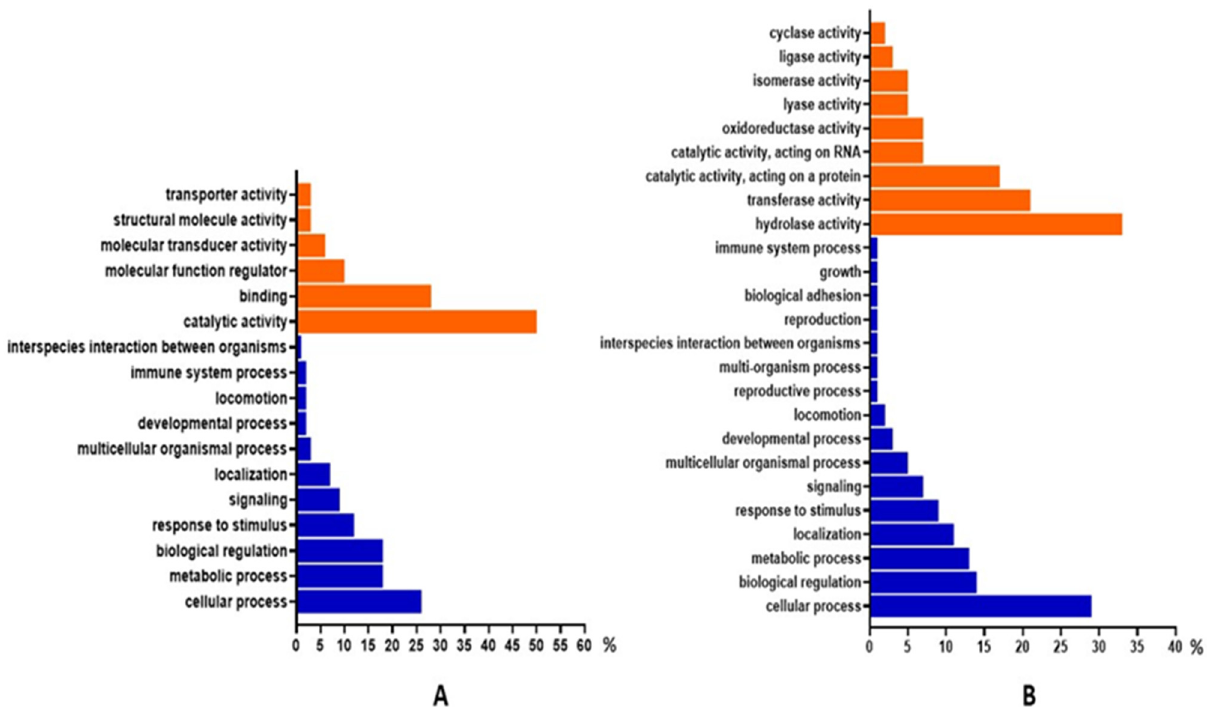
Figure 6. Gene ontology (GO) enrichment of ( A ) sperm intracellular proteins (SIPs) and ( B ) sperm membrane-associated proteins (SMAPs) of the dog ( Canis lupus familiaris ) cauda epididymal sper- matozoa. Significant GO terms for molecular function (orange) and biological process (blue) are presented. The analyses were made by the PANTHER Classification System (v. 16).